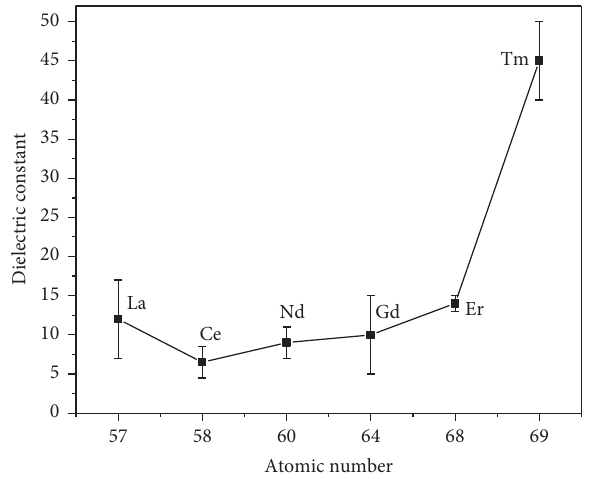
Figure 10: Variation of the dielectric constant of various rare earth metal-doped ZnO nanoparticles at 5% doping and at 1MHz fre- quency with respect to their atomic number.